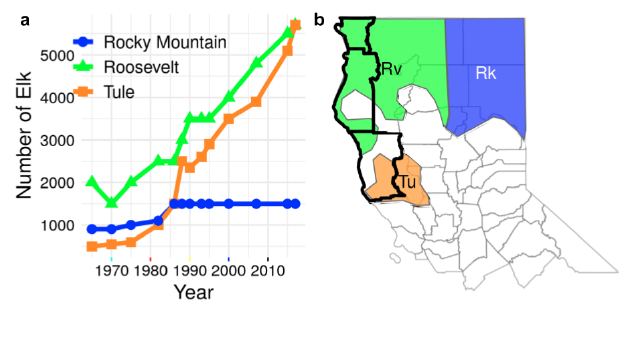
Fig. 1. (a) Statewide elk population estimates (1965–2017; green = Roosevelt elk; orange = Tule elk; blue = Rocky Mountain elk). (b) The current range of elk in northern California (green = Roosevelt elk; orange = Tule elk; blue = Rocky Mountain elk). The counties with bold outlines comprise the “North Coast” and is our study area. Reproduced from CDFW